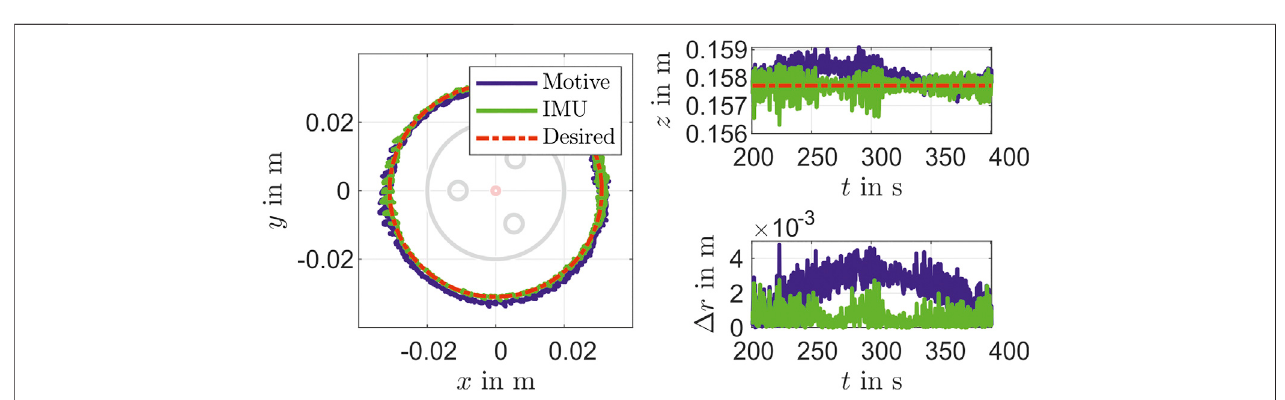
FIGURE 10 | Movement in a circular path in T (cid:1)